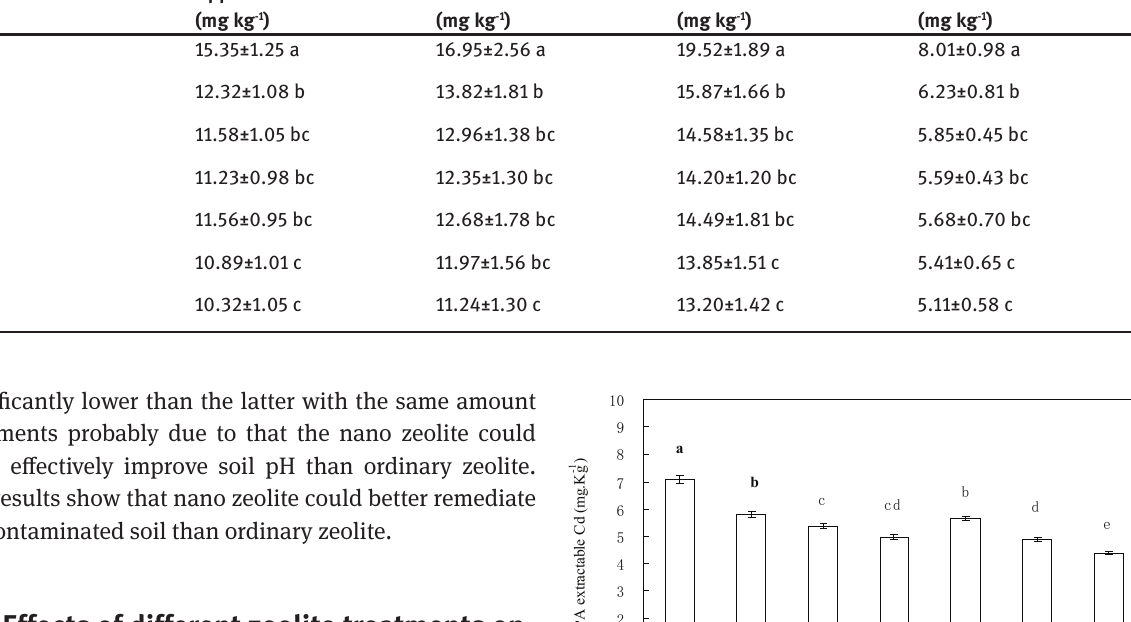
Table 1: Effects of ordinary zeolite and nano zeolite on Cd concentrations in various tissues of tobacco plants (Error bars indicate standard errors of 3 replicates. The different letters indicate significant difference at P< 0.05, similarly hereinafter).